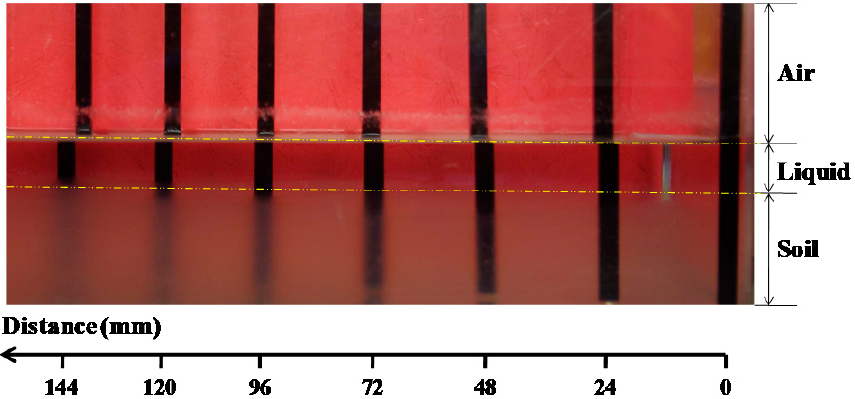
Figure 2. Sign viewed through different thicknesses of transparent material (e.g., fused quartz).